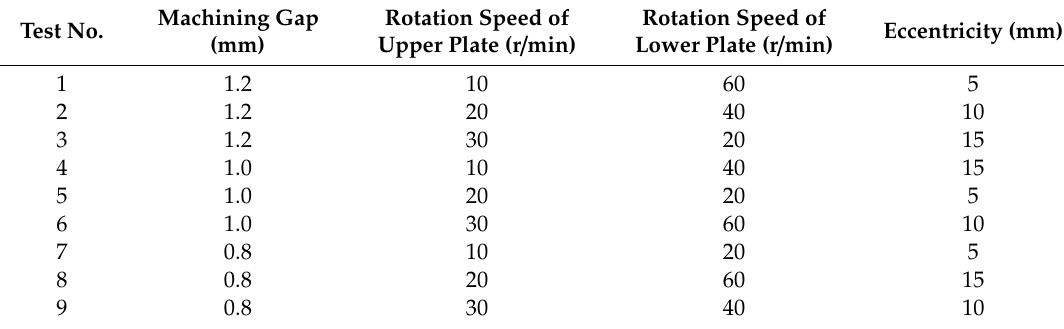
Table 3. Machining parameters of the orthogonal finishing